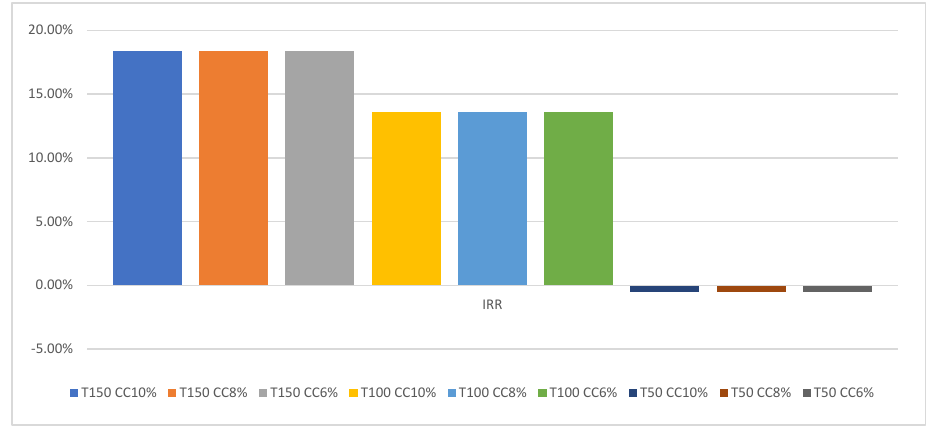
Figure 6. IRR results.